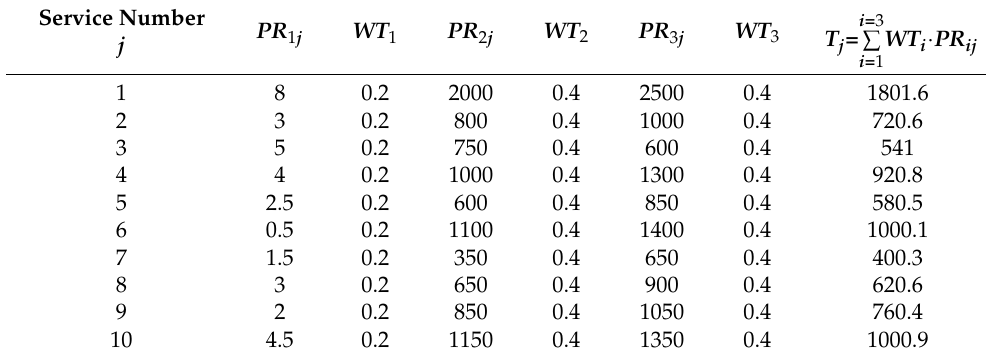
Table 2. Tracking the D1 services’ trust